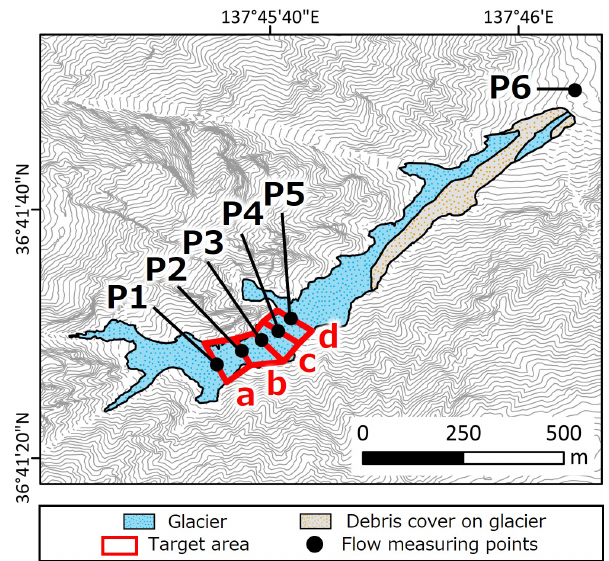
Figure 6. Target area for emergence velocity estimation and flow measurement point on the Karamatsuzawa Glacier. Contour interval is